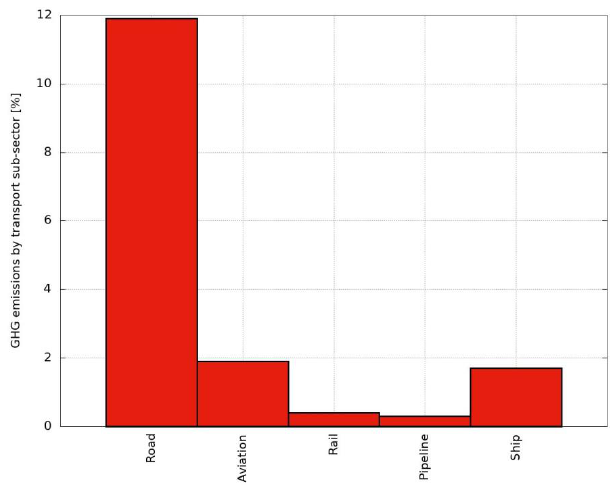
Figure 2. GHG emissions by transport sub-sector percentage (Data source [1]).